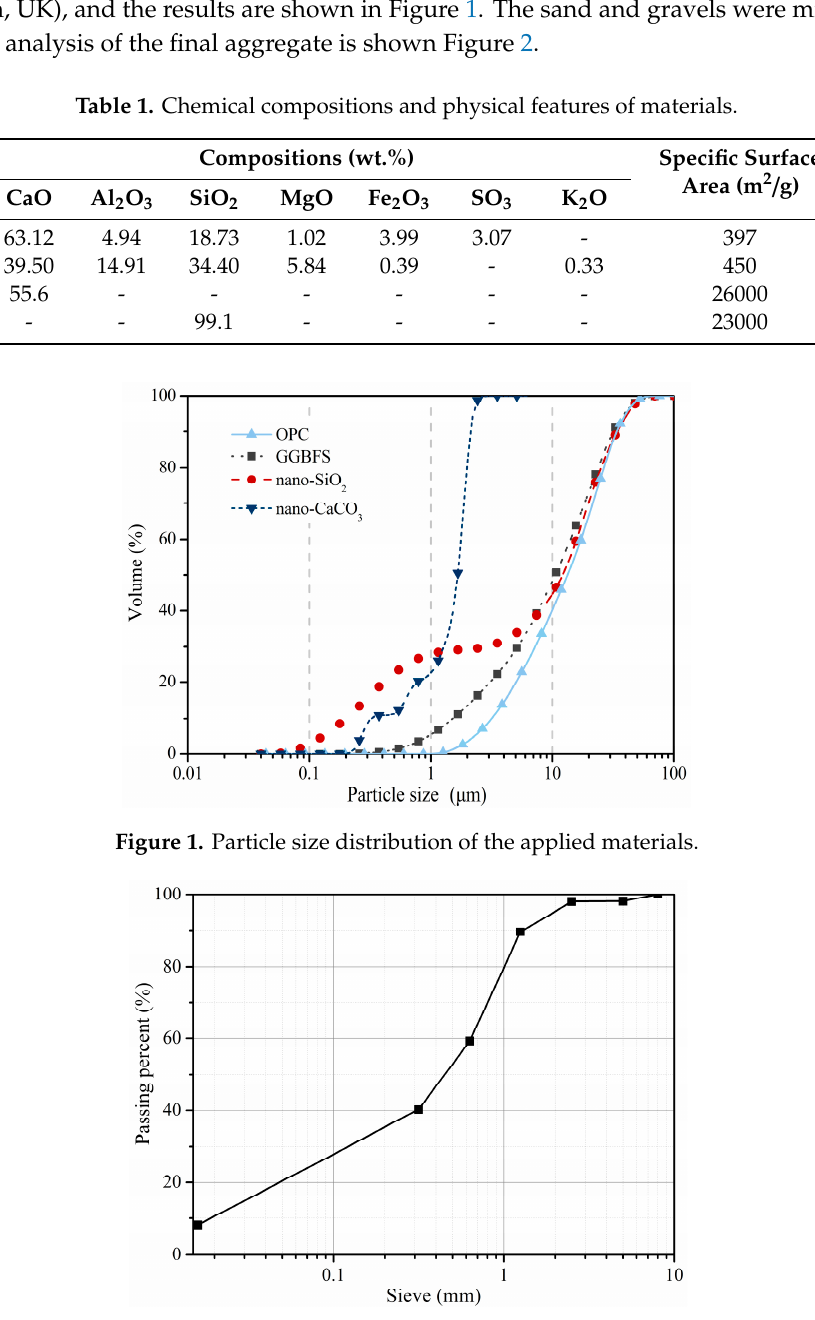
Figure 2. Sieve analysis of the used aggregate.